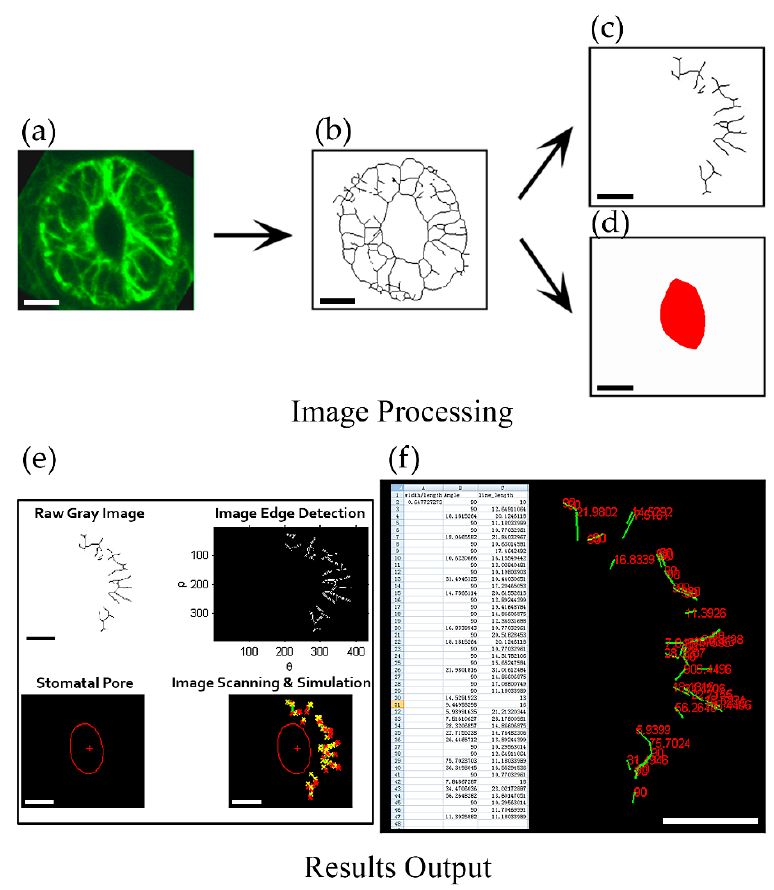
Figure 1. Framework of quantification of angle values in individual actin filaments in guard cell. ( a ) The obtained image of the maximum intensity projection of serial optical sections with GFP-marked actin filaments in guard cell; ( b ) The skeletonized image of actin filaments in ( a ) [5]. ( c ) Dividing the skeletonized filaments of the guard cell in the right part of stomata and saving it as a JPEG format file. ( d ) Drawing the stomatal pore region by red color and saving it as a JPEG format file. ( e ) Image detection and identification after inputting two images of the skeletonized filaments ( c ) and the stomatal pore region ( d ) into GCMA software (see details in supplemental PPT). The image on the